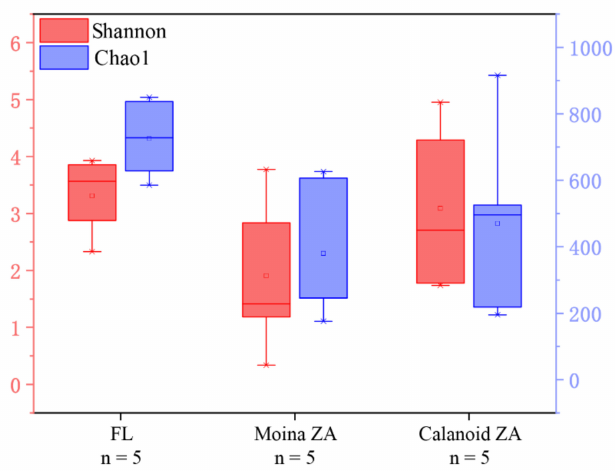
Figure 4. Species richness and Shannon diversity index between microbial communities associated with Moina and Calanoids in five freshwater